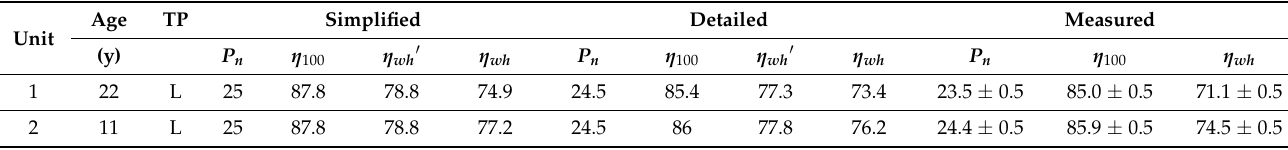
Table 4. Laboratory test compared with the